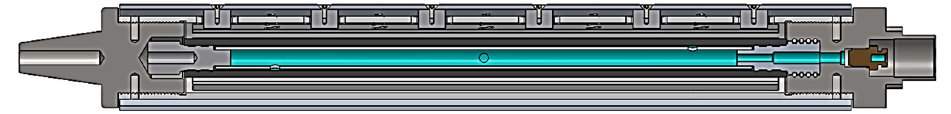
Figure 11. Sectional view of the YZ plane of the expandable pneumatic shaft’s mechanism. The airless shaft remains retracted by the action of conical springs, as depicted in Figure 12.